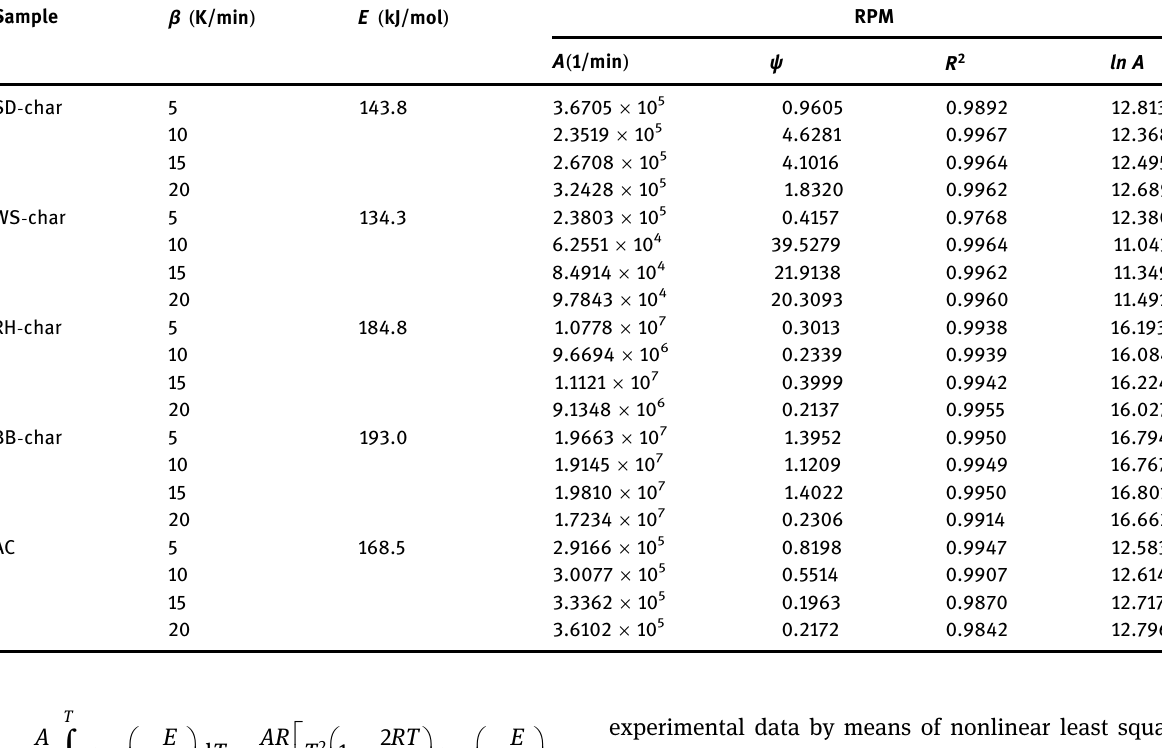
experimental data by means of nonlinear least squares fi tting methods. Table 3 shows the mean E α values calculated by using the NL - INT method and the fi tted parameters ( A and ψ ) determined from the data obtained at di ff erent heating rates for each sample. Figure 5 shows a comparison of experimental and fi tted conversion degree as a function of reaction temperature for ( a ) SD -